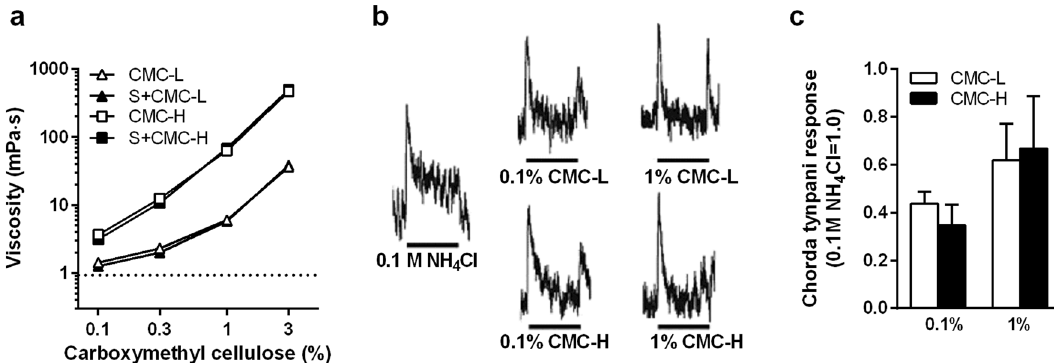
Figure 1. Mean viscosities and integrated whole chorda tympani responses to carboxymethyl cellulose (CMC) of low- or high-viscosity type. Mean ± standard error of the mean. CMC-L, low-viscosity CMC fluid; S + CMC-L, saccharin-containing CMC-L fluid; CMC-H, high-viscosity CMC fluid; S + CMC-H, saccharin- containing CMC-H fluid. ( a ) Mean viscosities of CMC-containing water with or without 0.08% saccharin (3 measurements). Both x- and y-axes are logarithmic scales. ( b ) Representative integrated whole chorda tympani. Viscous fluid stimuli were applied for 20 s as indicated by underlines. ( c ) Relative magnitude of responses of the chorda tympani to viscous fluid stimuli (each bar, n = 5). The response magnitude is expressed when the magnitude of the response to 0.1 M ammonium chloride (NH 4 Cl) is taken as 1.0.